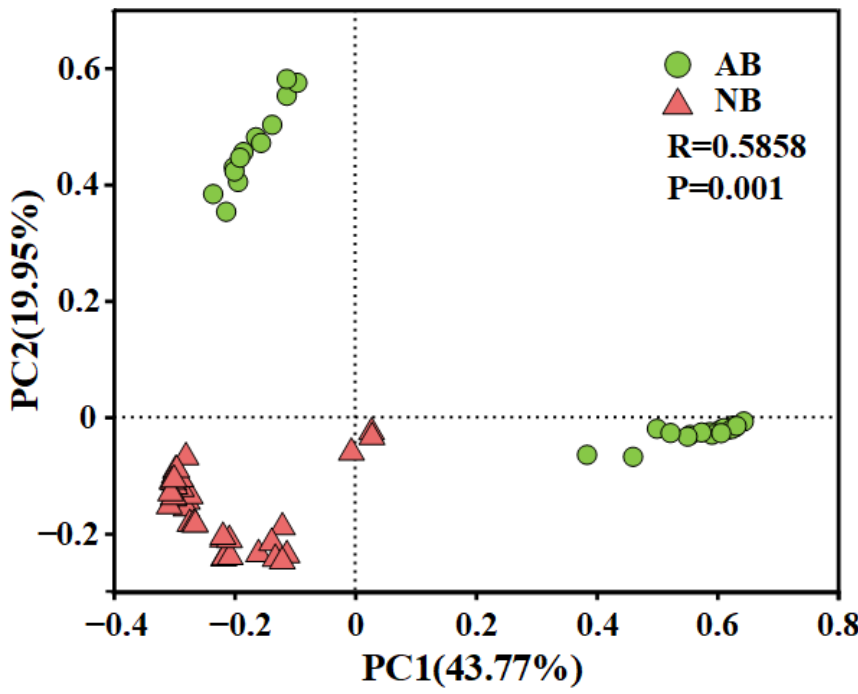
Figure 1. PCoA principal coordinate analysis of B. calyciflorus -associated bacterial and bacterio- ton plankton communities.